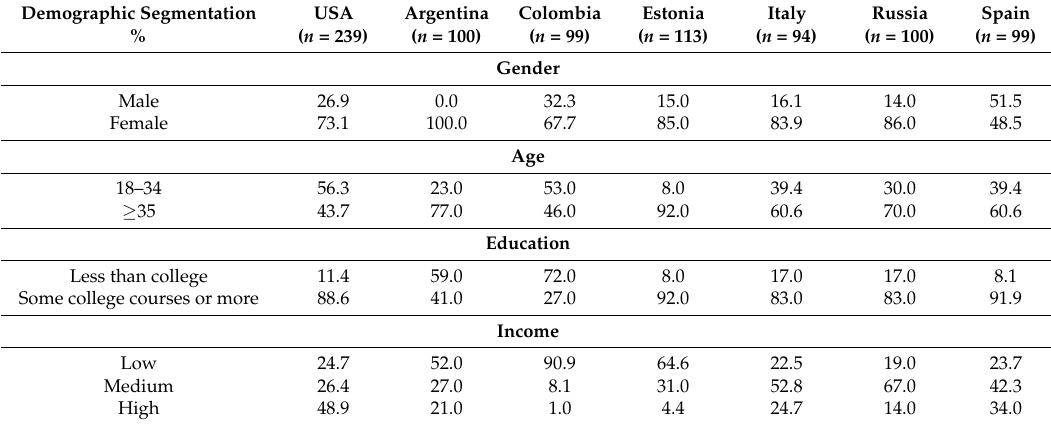
Table 1. Participant demographics in percentages by